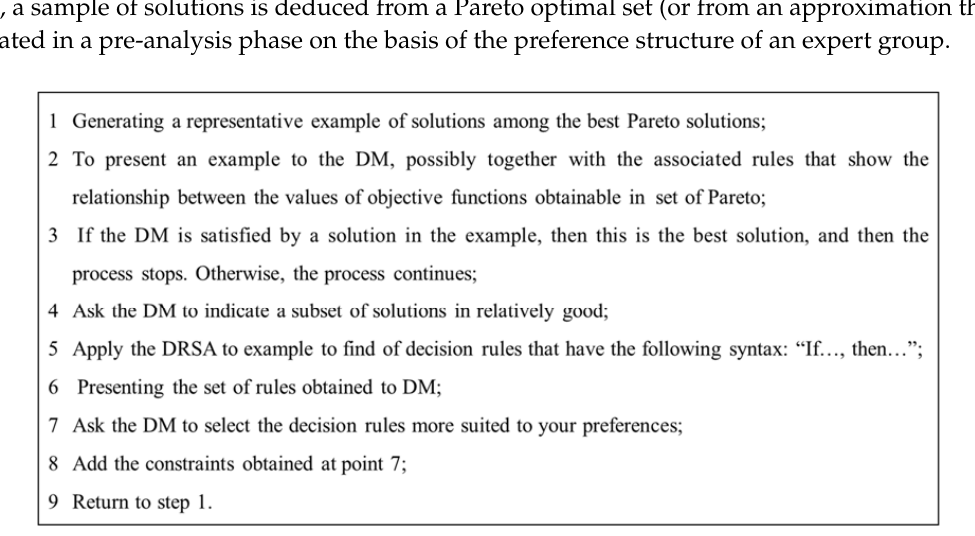
Figure 5. The Interactive Multi-objective Optimization-Dominance-Based Rough Set Approach (IMO-DRSA) flowchart.